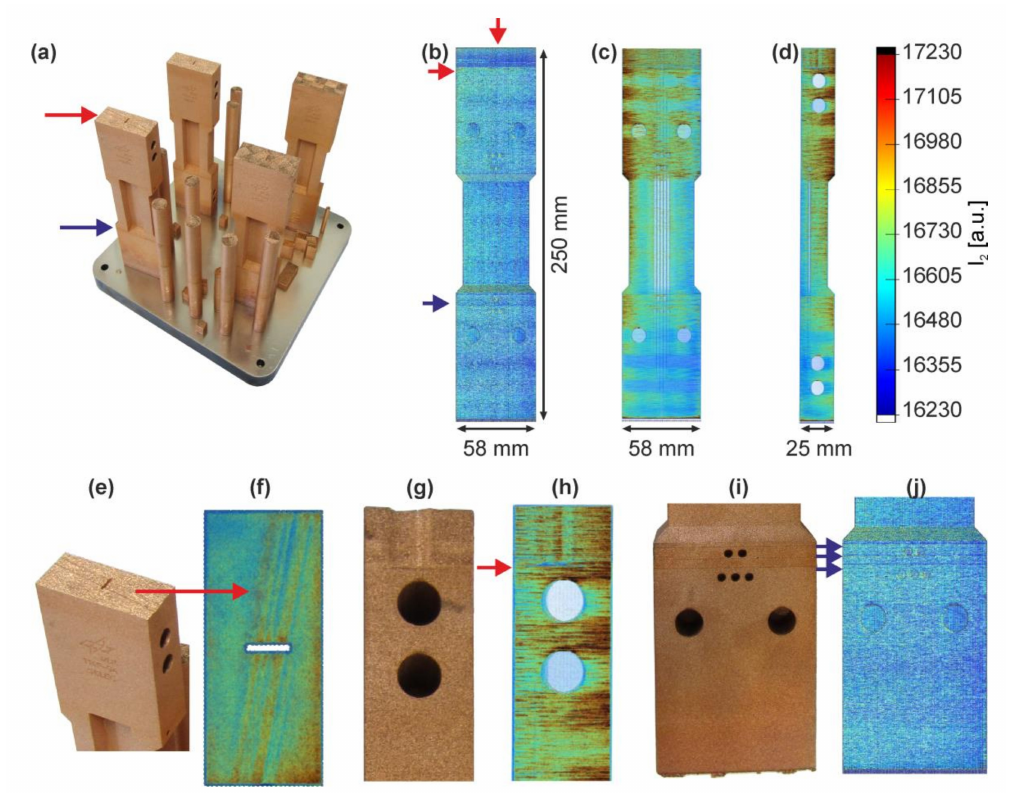
Figure 13. ( a ) The CuCr1Zr-TMF-panel build; ( b – d ) MPM data visualization (voxel size of 0.15 × 0.15 × 0.15 mm 3 ) of a TMF-panel with 2 di ff erent transparency setting; ( b ) the surface view; ( c , d ) the visible hotspots and internal structure; ( e , f ) the comparison between the visible defects at the top surface and the MPM data (red arrows); ( g , h ) the same defect viewed from the panel’s short side shows a defect extending 12.5 mm in height; ( I , j ) the lower section of this panel and MPM response shows three distinct horizontal lines (blue